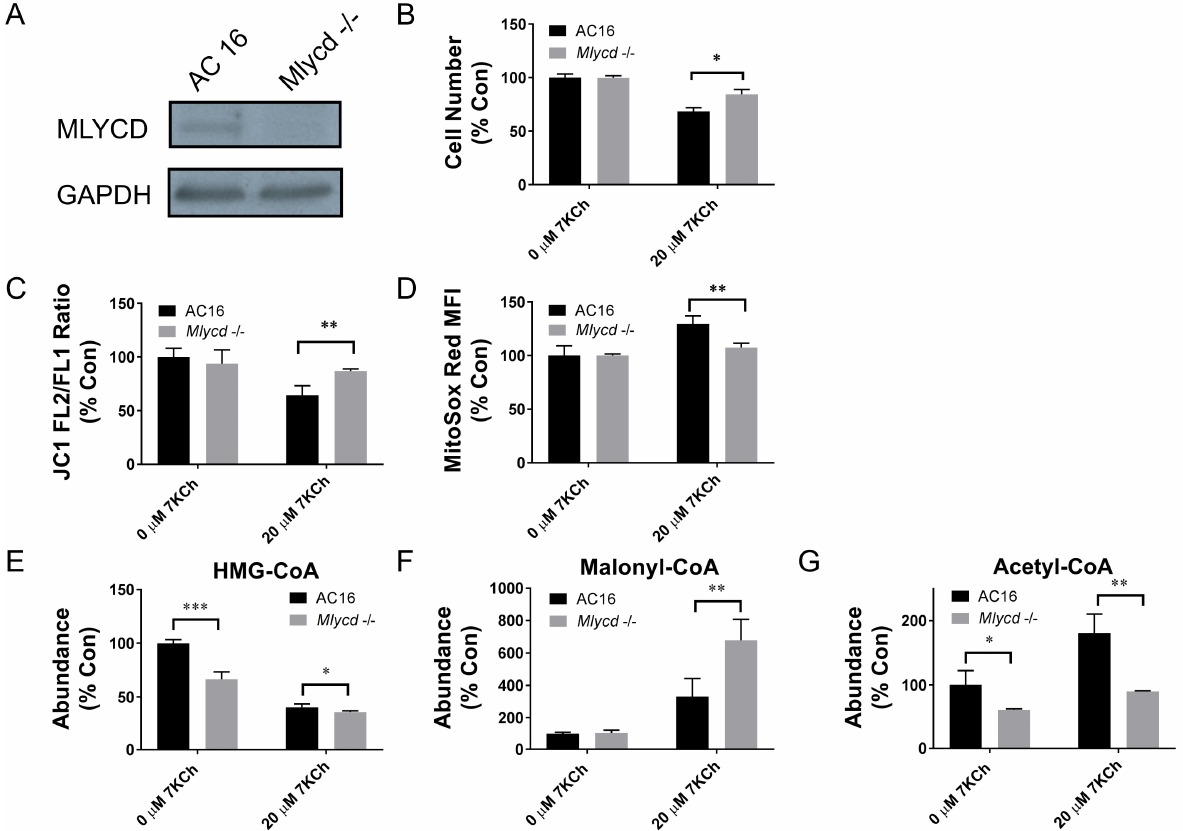
Figure 7. Knockout of the Mlycd gene restores mitochondrial functions and counteracts the growth inhibitory effect of 7KCh. ( A ) The Mlycd − / − and control AC16 cells were analyzed for the expression of MLYCD and GAPDH by immunoblotting. A representative of three experiments is shown. ( B ) The Mlycd − / − and control AC16 cells were treated with 0 (i.e., the vehicle control) or 20 μ M 7KCh for 24 h and stained with Hoechst 33342. The cell number was quantified using IN Cell Analyzer 1000 and is expressed as the percentage relative to the untreated AC16 cells. Data are mean ± SD of six experiments. * p < 0.05 vs. AC16 cells. ( C , D ) The Mlycd − / − and control AC16 cells were treated with the indicated concentrations of 7KCh for 24 h and stained with JC1 ( C ) or MitoSOX red ( D ). The ratio of the MFI of FL2 channel to that of FL1 channel (i.e., JC1 FL2/FL1 ratio) was calculated and is expressed as the percentage relative to that of the untreated AC16 cells. The MFI of the MitoSOX red-stained cells is expressed as the percentage relative to that of the untreated AC16 cells. Data are mean ± SD, N = 6. ** p < 0.01 vs. AC16 cells. ( E – G ) The Mlycd − / − and control AC16 cells were similarly treated with 7KCh and extracted for the quantification of HMG-CoA, malonyl-CoA, and acetyl-CoA. The abundances of these metabolites are expressed as the percentage relative to those of the untreated AC16 cells. Data are mean ± SD, N = 6. * p < 0.05, ** p < 0.01, *** p < 0.005 vs. AC16